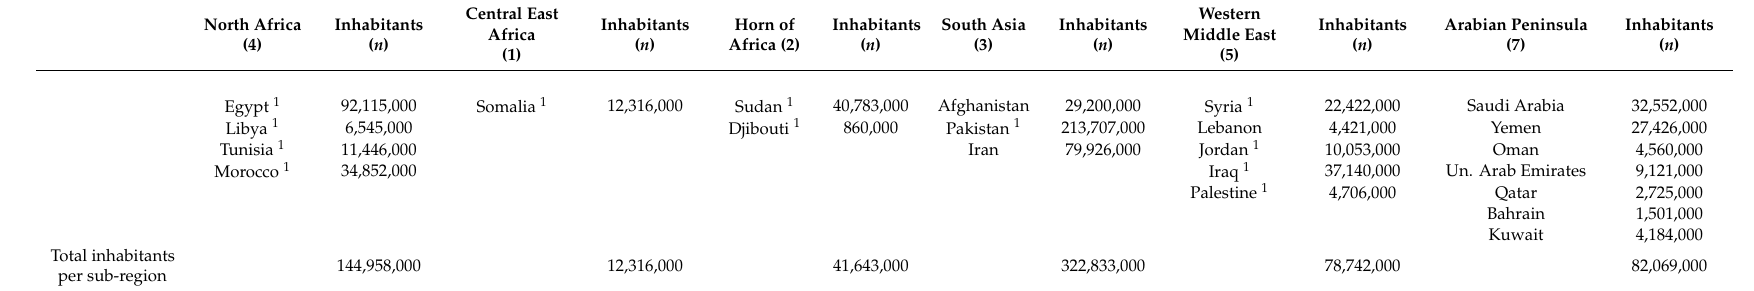
Table 1. EMR countries identified according to WHO classification and divided into six geographic